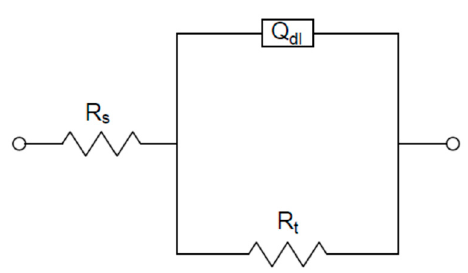
Figure 6. Equivalent circuit used for fitting electrochemical impedance spectroscopy (EIS) experimental data.